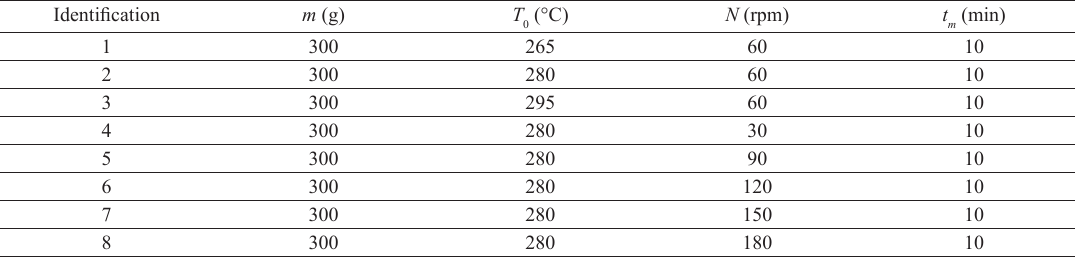
Table 1. Operation